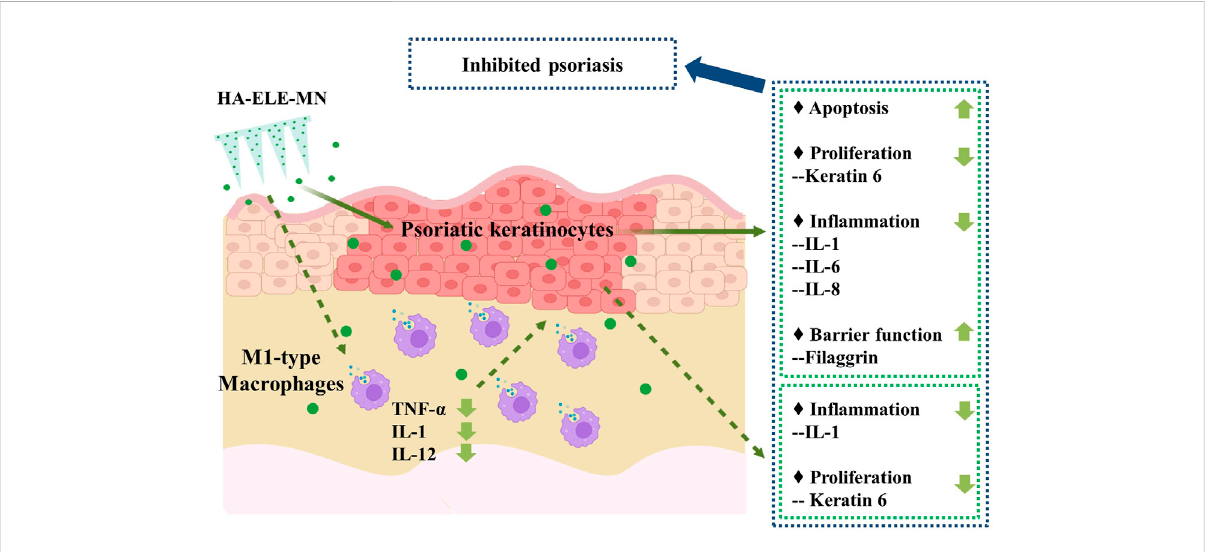
FIGURE 7 Potential mechanismsofELEonpsoriasis treatment.ELEdirectly inducesapoptosisinpsoriatic keratinocytes andinhibitspsoriatickeratinocyte in fl ammation by down-regulating the expression of IL-1, IL-6, and IL-8. ELE may also reduce psoriatic keratinocyte proliferation by decreasing the expressionofkeratin6andhelptomaintainthebarrierfunctionofkeratinocytesbystimulatingtheexpressionof fi laggrin.Inaddition,ELEattenuates the expression of TNF- α , IL-1, and IL-12 in M1-Mø, which indirectly suppresses the in fl ammation and proliferation of psoriatic keratinocytes by attenuating the expression of IL-1 and keratin